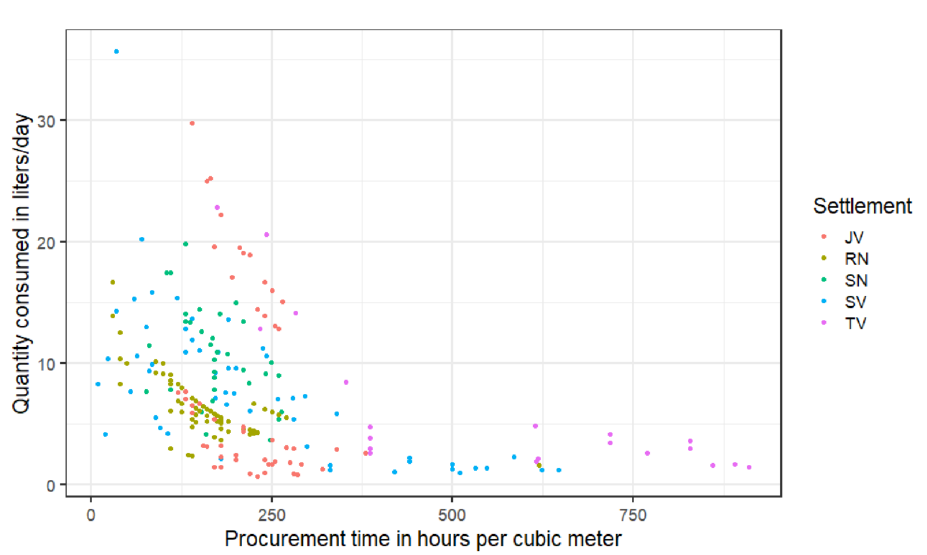
Figure A1. Consumed quantity of water for each measured day against the procurement time, calculated in hours per cubic meter.